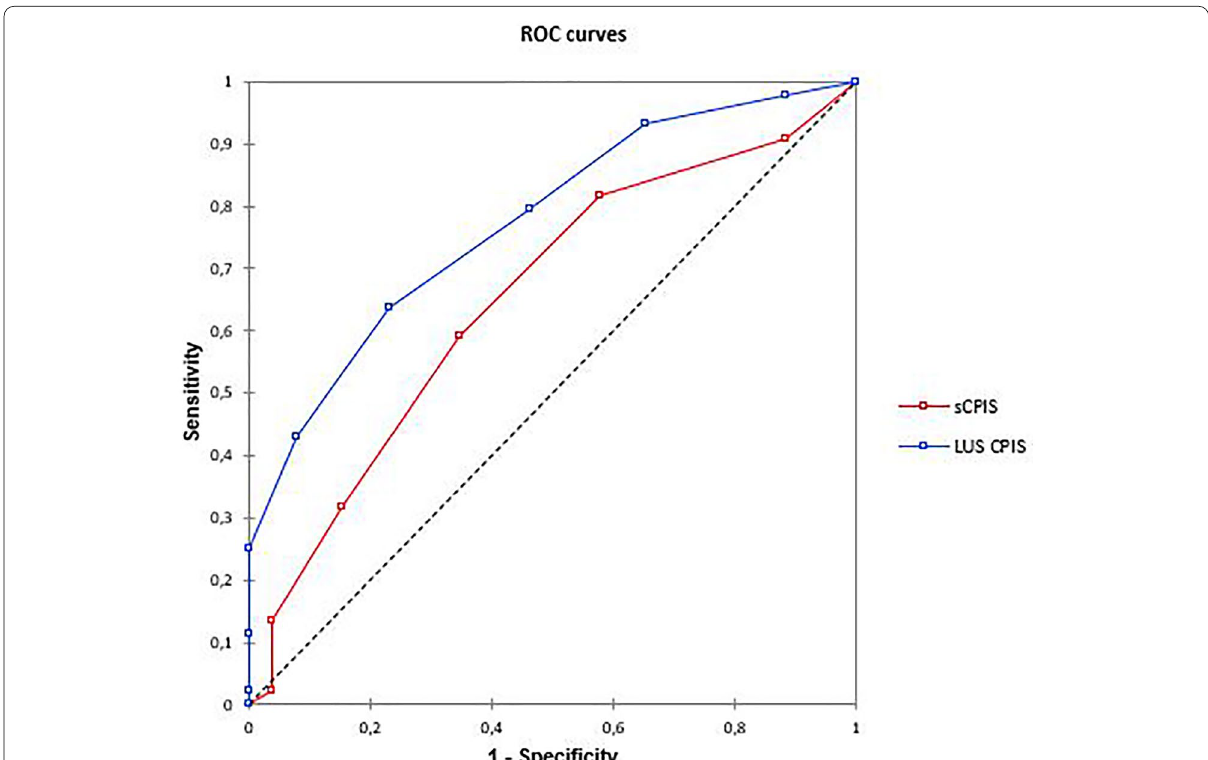
Fig. 2 Receiver operating characteristic (ROC) curves of simplified Clinical Pulmonary Infection Score and Lung ultrasound‑simplified Clinical Pulmonary Infection Score. LUS lung ultrasound; sCPIS simplified Clinical Pulmonary Infection = =